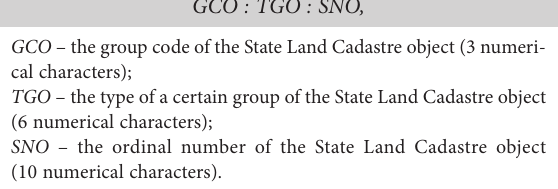
Figure 3. The structure of the registration number of the State Land Cadastre objects (PKMU, 2012, art. 28)